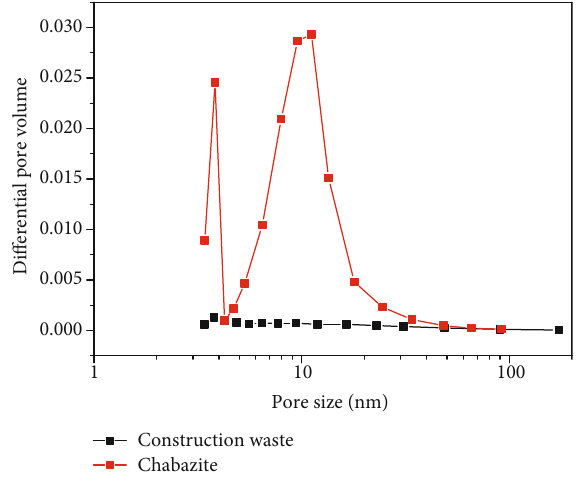
Figure 5: Pore structure distribution of construction waste and